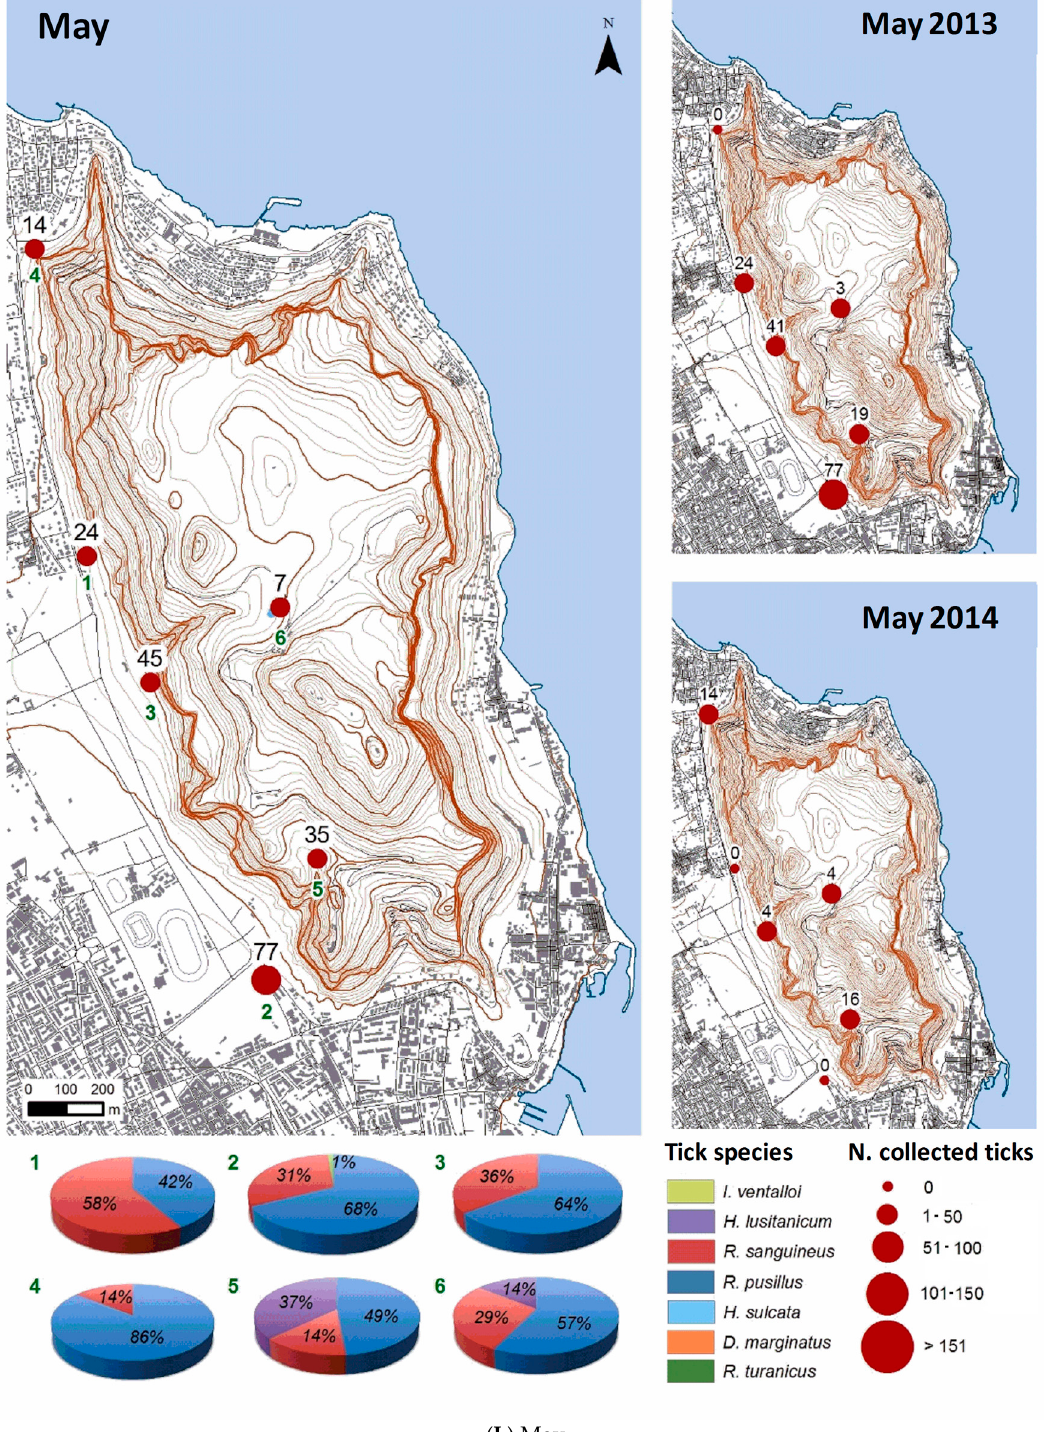
Figure 8. ( A – L ) Monthly maps related to the two years of monitoring from June ( A ) to May ( L ). Circle sizes in the maps are proportional to the number of ticks collected in the monitored sites. Each map reports not only a monthly value as a result of the two ‐ year period, but also the values separately for each year of the study. At the bottom of each monthly map, charts showing tick species composition in each collection site are reported.